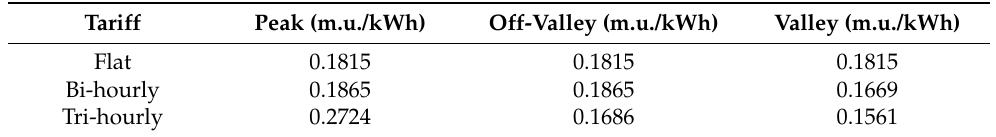
Table 2. Energy tariffs for the scheduling phase.